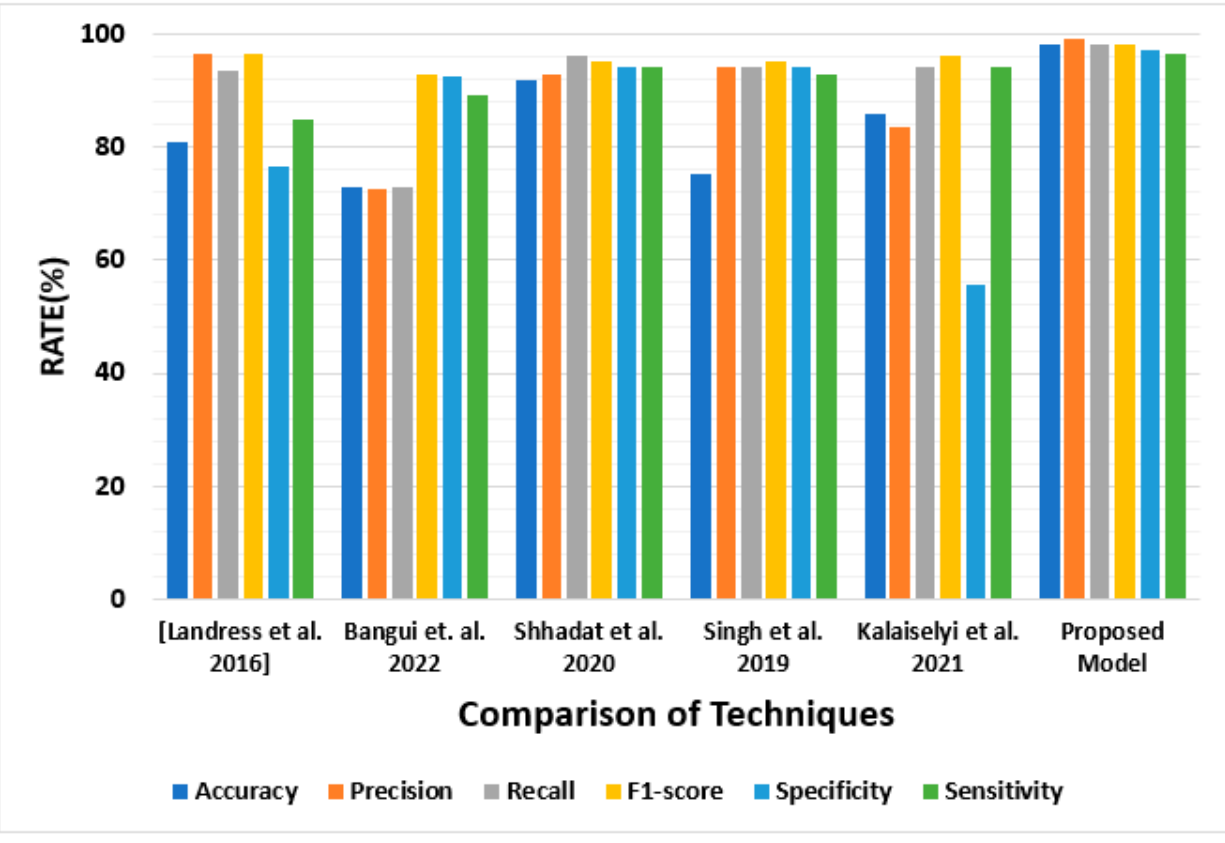
Figure 20. Comparison of the proposed model (IVSDDM) with previous research works [41–44]. Table 8. Comparison of the results with existing approaches.